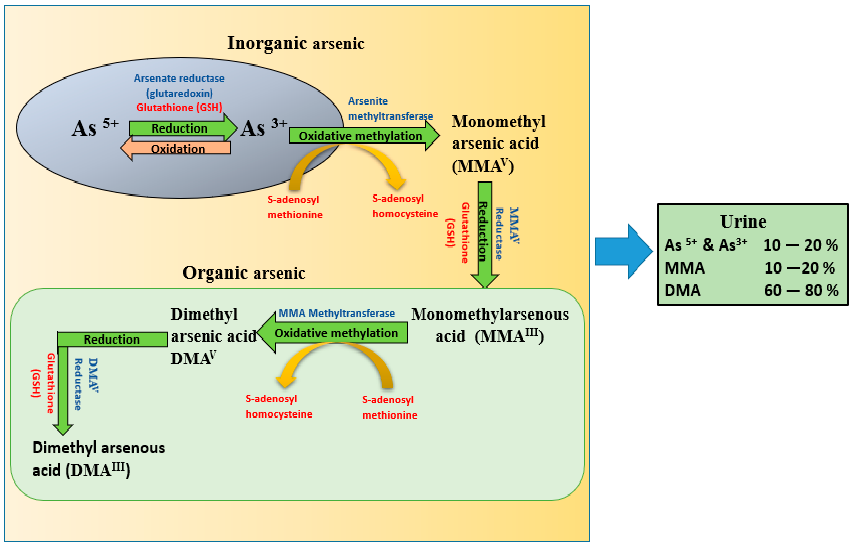
Figure 1. Metabolic pathway of inorganic arsenic demonstrating the reduction of arsenate to arse- nite with the enzyme arsenate reductase mediated by glutathione (GSH), which further undergoes oxidative methylation through the enzyme arsenite methyltranferase mediated by S-adenosyl me- thionine, with conversion to MMA and DMA. Finally, all the metabolites are excreted through urine, among which DMA is the major metabolite (60–80%). (As- arsenic, DMA-dimethyl arsenic acid, MMA-monomethyl arsenic acid,